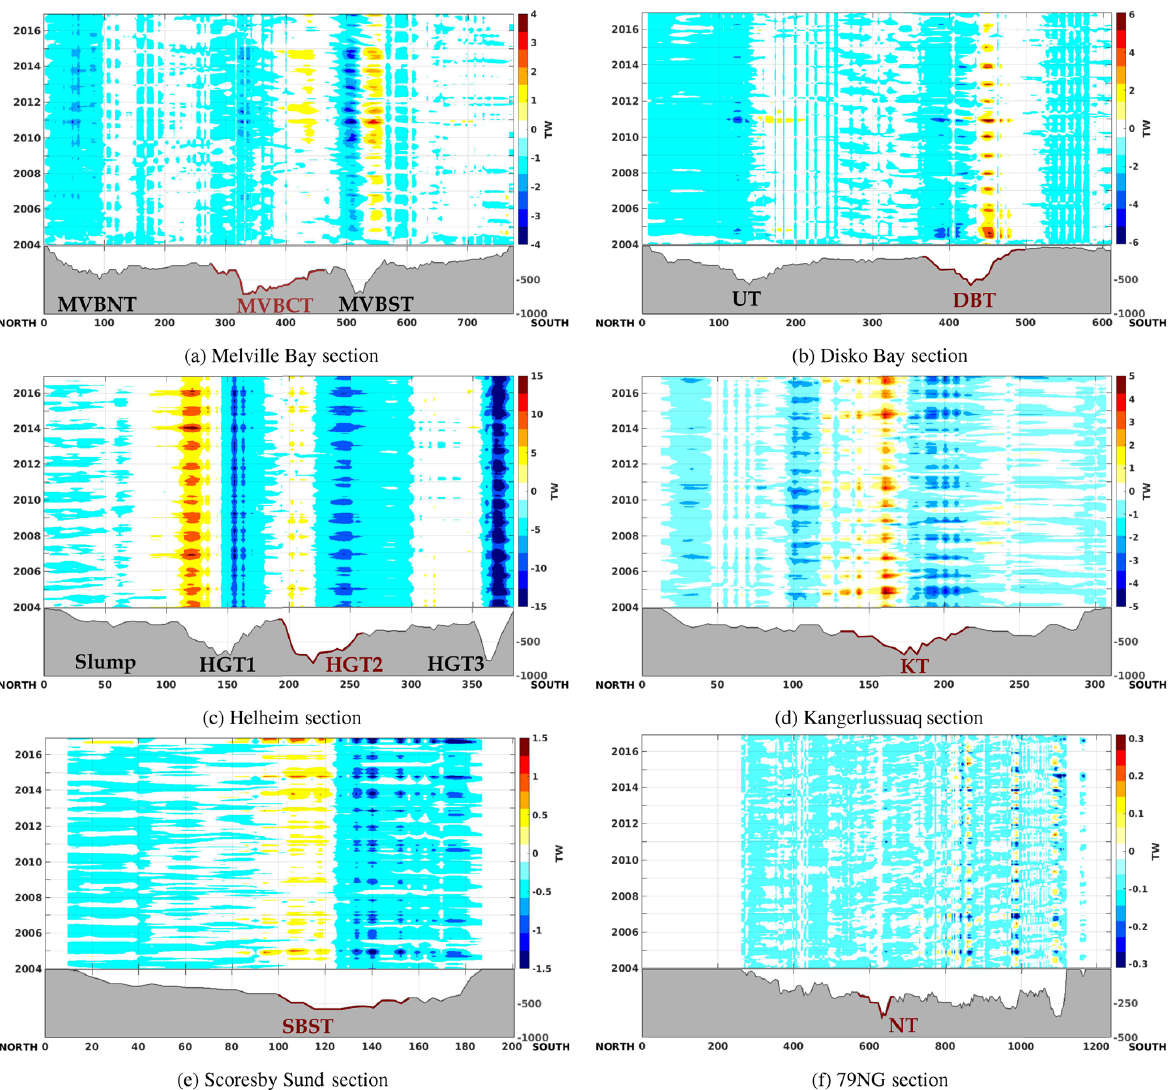
Figure 9. This figure shows the entire ocean heat exchange (total flux) with respect to topography (in grey) within the time series from 2004 to the end of 2016 with the HighRes model output. These Hovmöller plots show the monthly average heat flux coming on or off the shelf in TW, through a section (sections drawn in light purple on the map inset Fig. 1). Model bathymetry is in grey and the section runs north to south on the x axis, starting at the left-hand side of the figure indicated by the 0km marker. Along the y axis is the depth for the bathymetry and then time for the 2004 to 2016 period. Colours indicate the direction and magnitude of the onshore or offshore heat flux. Positive numbers indicate the direction of onshore heat flux, and negative numbers indicate the direction of the heat flux offshore. Colour bar limits change per location. Each section shows a highlighted trough in dark red, which is selected for Figs. 10 and 11. Figure 1 indicates the exact location of the trough as tan